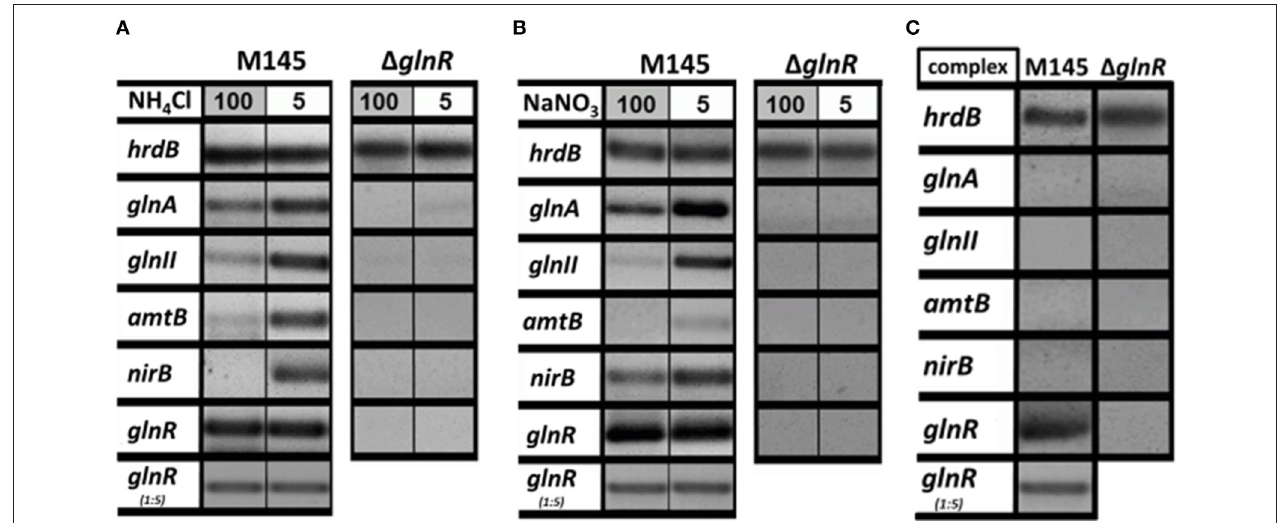
FIGURE 1 | Transcriptional analysis of the selected GlnR target genes under variable nitrogen and carbon conditions. (A) RT-PCR of glnA , glnII , amtB , nirB , and glnR in S. coelicolor M145, and glnR mutant cultivated in defined Evans medium with low (5mM) or high (100mM) concentrations of ammonium chloride as sole nitrogen source. (B) RT-PCR of glnA , glnII , amtB , nirB , and glnR in S. coelicolor M145 and glnR mutant cultivated in defined Evans medium with low (5mM) or high (100mM) sodium nitrate as sole nitrogen source. (C) RT-PCR of glnA , glnII , amtB , nirB , and glnR in S. coelicolor M145 and glnR mutant cultivated under complex